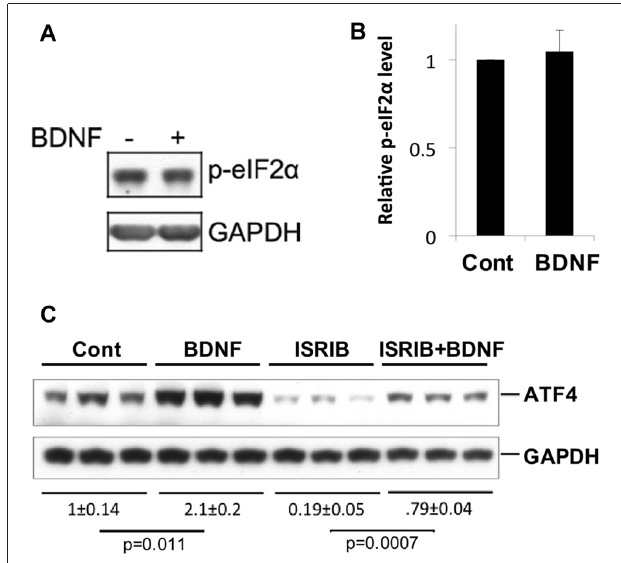
FIGURE 5 | BDNF does not elevate ATF4 protein via a phospho-eIF2 α -dependent mechanism. (A,B) BDNF treatment (4 h, 25 ng/ml) does not affect levels of phospho-eIF2 α in cultures of hippocampal neurons. Left panel shows representative Western immunoblot, right panel quantification (mean ± SEM for five independent experiments, each performed on a single lysate per condition). (C) Inhibition of phospho-eIF2 α -dependent protein synthesis by Integrated Stress Response inhibitor (ISRIB; 50 nM) does not block the capacity of BDNF to elevate ATF4 protein levels in cultured hippocampal neurons. Replicate cultures were pre-treated ± ISRIB or diluent (DMSO) for 1 h and then for an additional 4 h ± BDNF in the continued presence of diluent or ISRIB and then whole cell extracts were subjected to Western-immunoblotting. The blot image was scanned and relative levels of ATF4 (normalized to GAPDH as loading control) determined and indicated below the blot (values are means ± SEM for the three replicates for each condition). The indicated p values were calculated by the t -test. Similar results were achieved in two additional independent